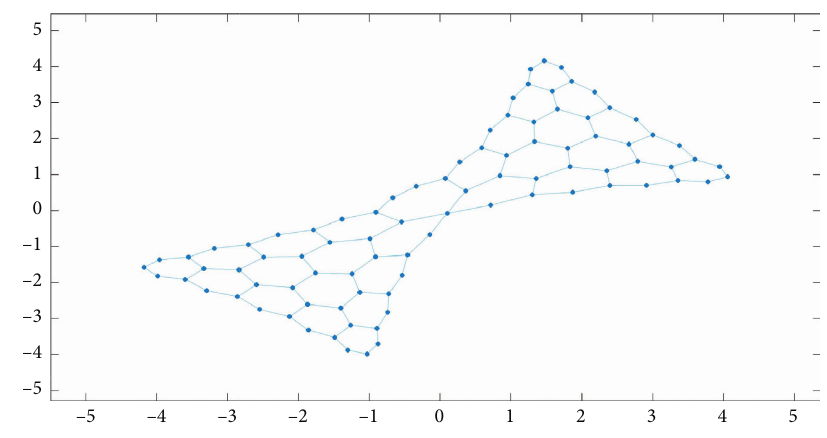
Figure 3: Hourglass carbon nanocone HGSCNC ( 4 , 7 )